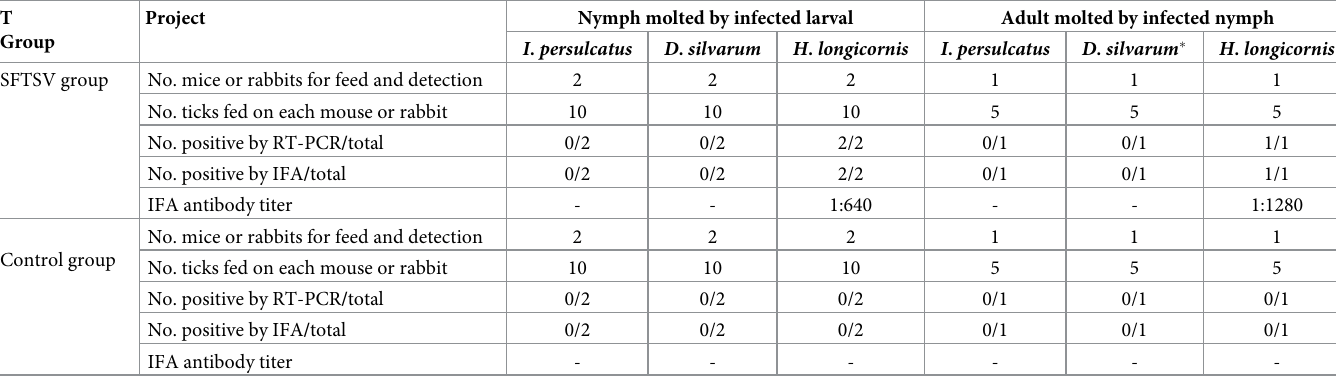
Table 4. Animals used in the transstadial transmission cycle of SFTSV for three tick species.